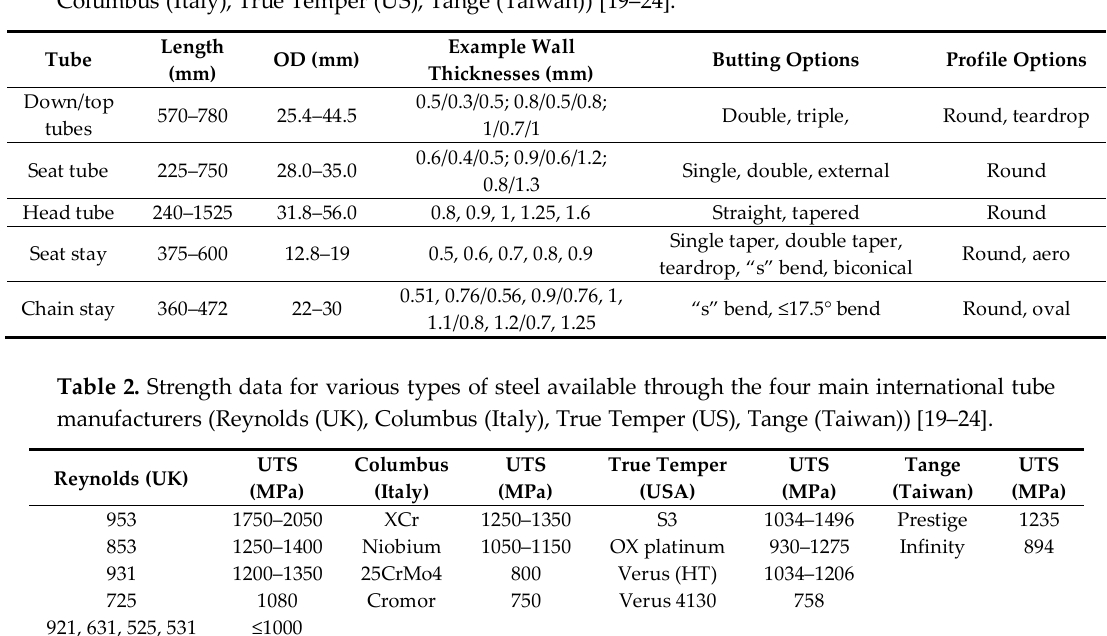
Table 1. Typical tube details from the four main international tube manufacturers (Reynolds (UK), Columbus (Italy), True Temper (US), Tange (Taiwan)) [19–24].